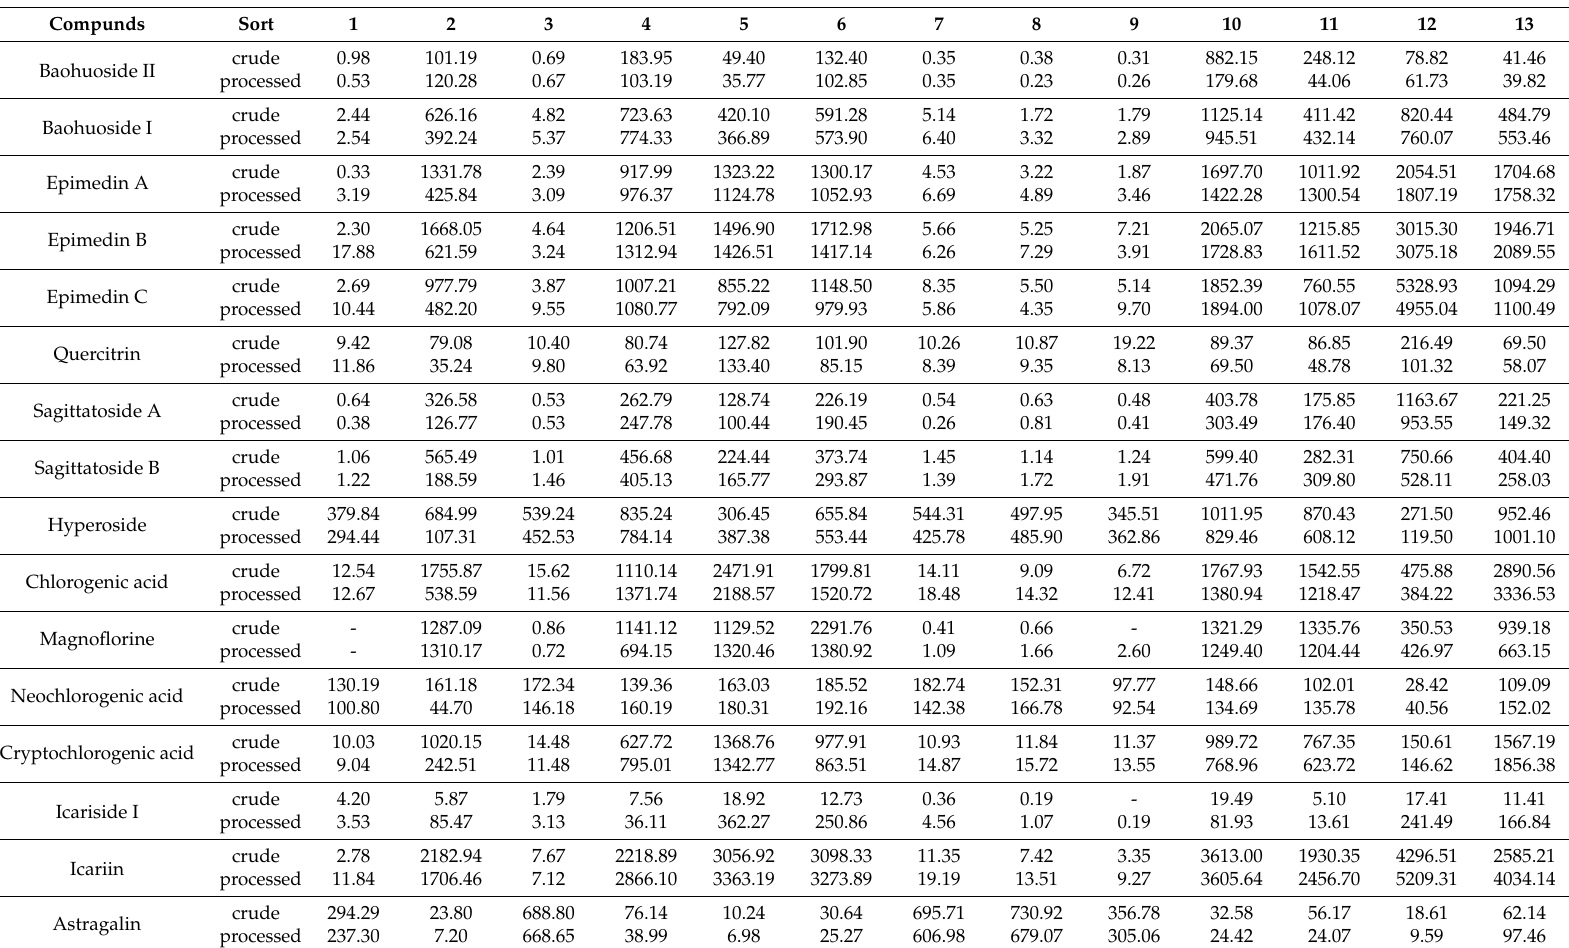
Table 4. The contents of 16 compounds in Epimedium samples ( µ